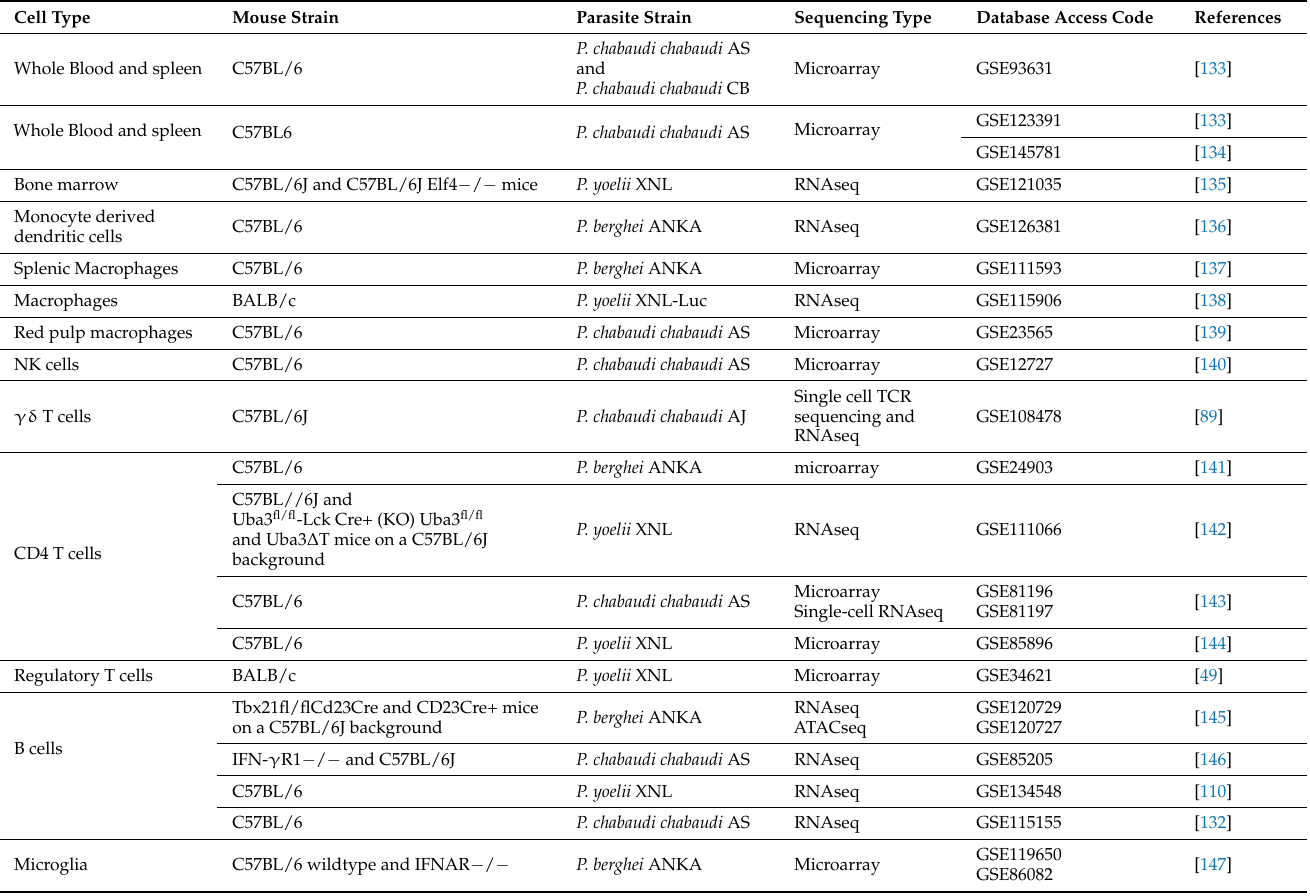
Table 5. Published and publicly available databases of sequencing data from rodent Plasmodium